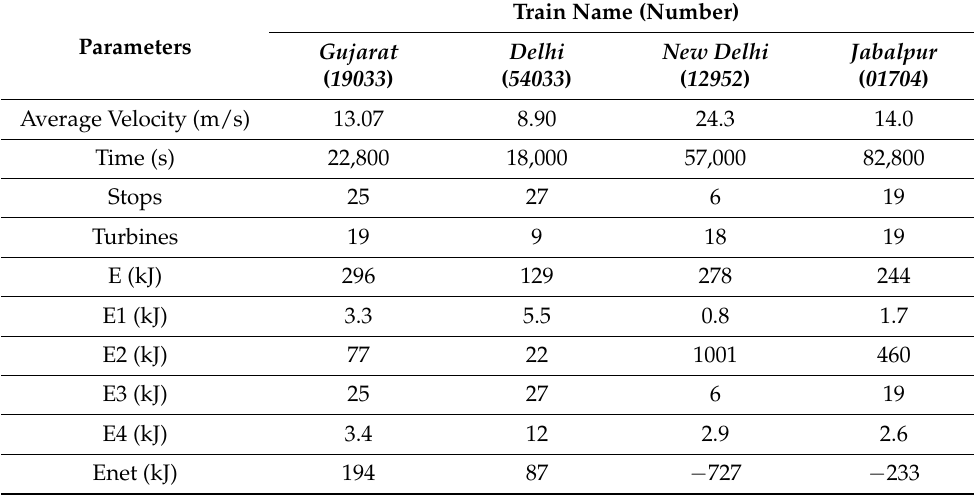
Table 3. Comparison of Energy Components.